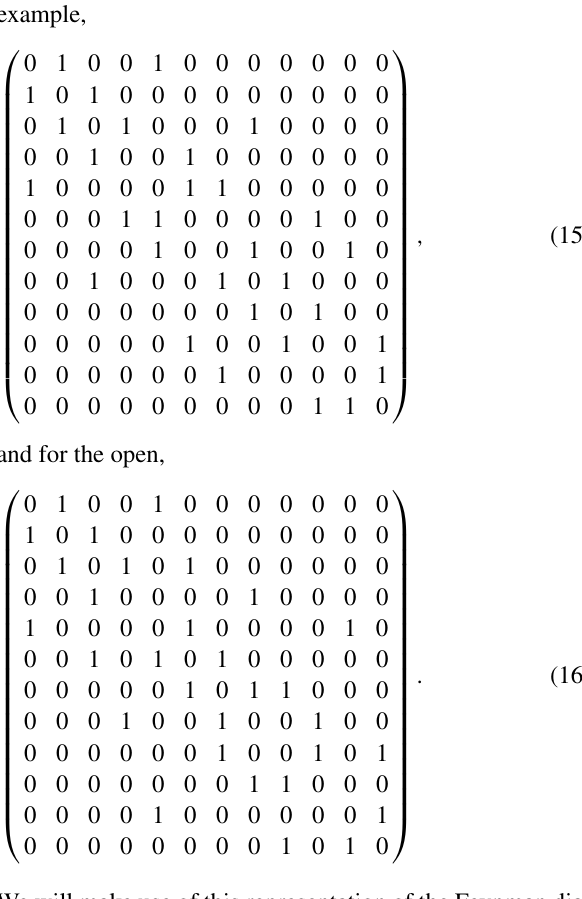
Fig. 2 Two typical diagrams with six rungs. Open spin chain topology to the left (labeled {L, R, L, R, R, L}) and closed spin chain topology to the right (labeled {L, R, M, L, R, M})